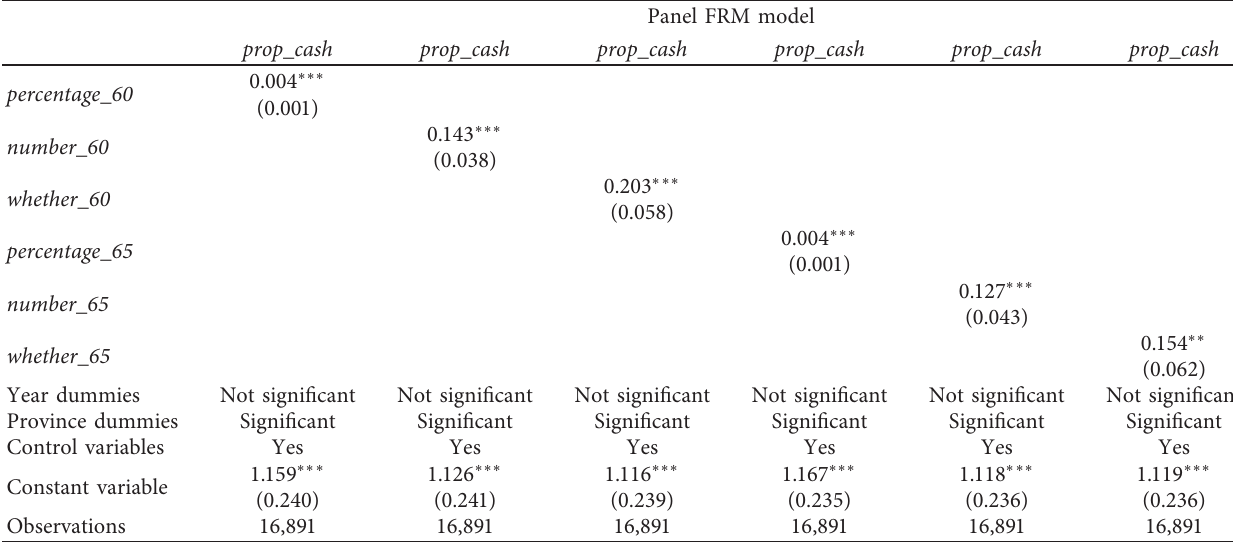
Table 5: Results on the proportion of families’ cash and